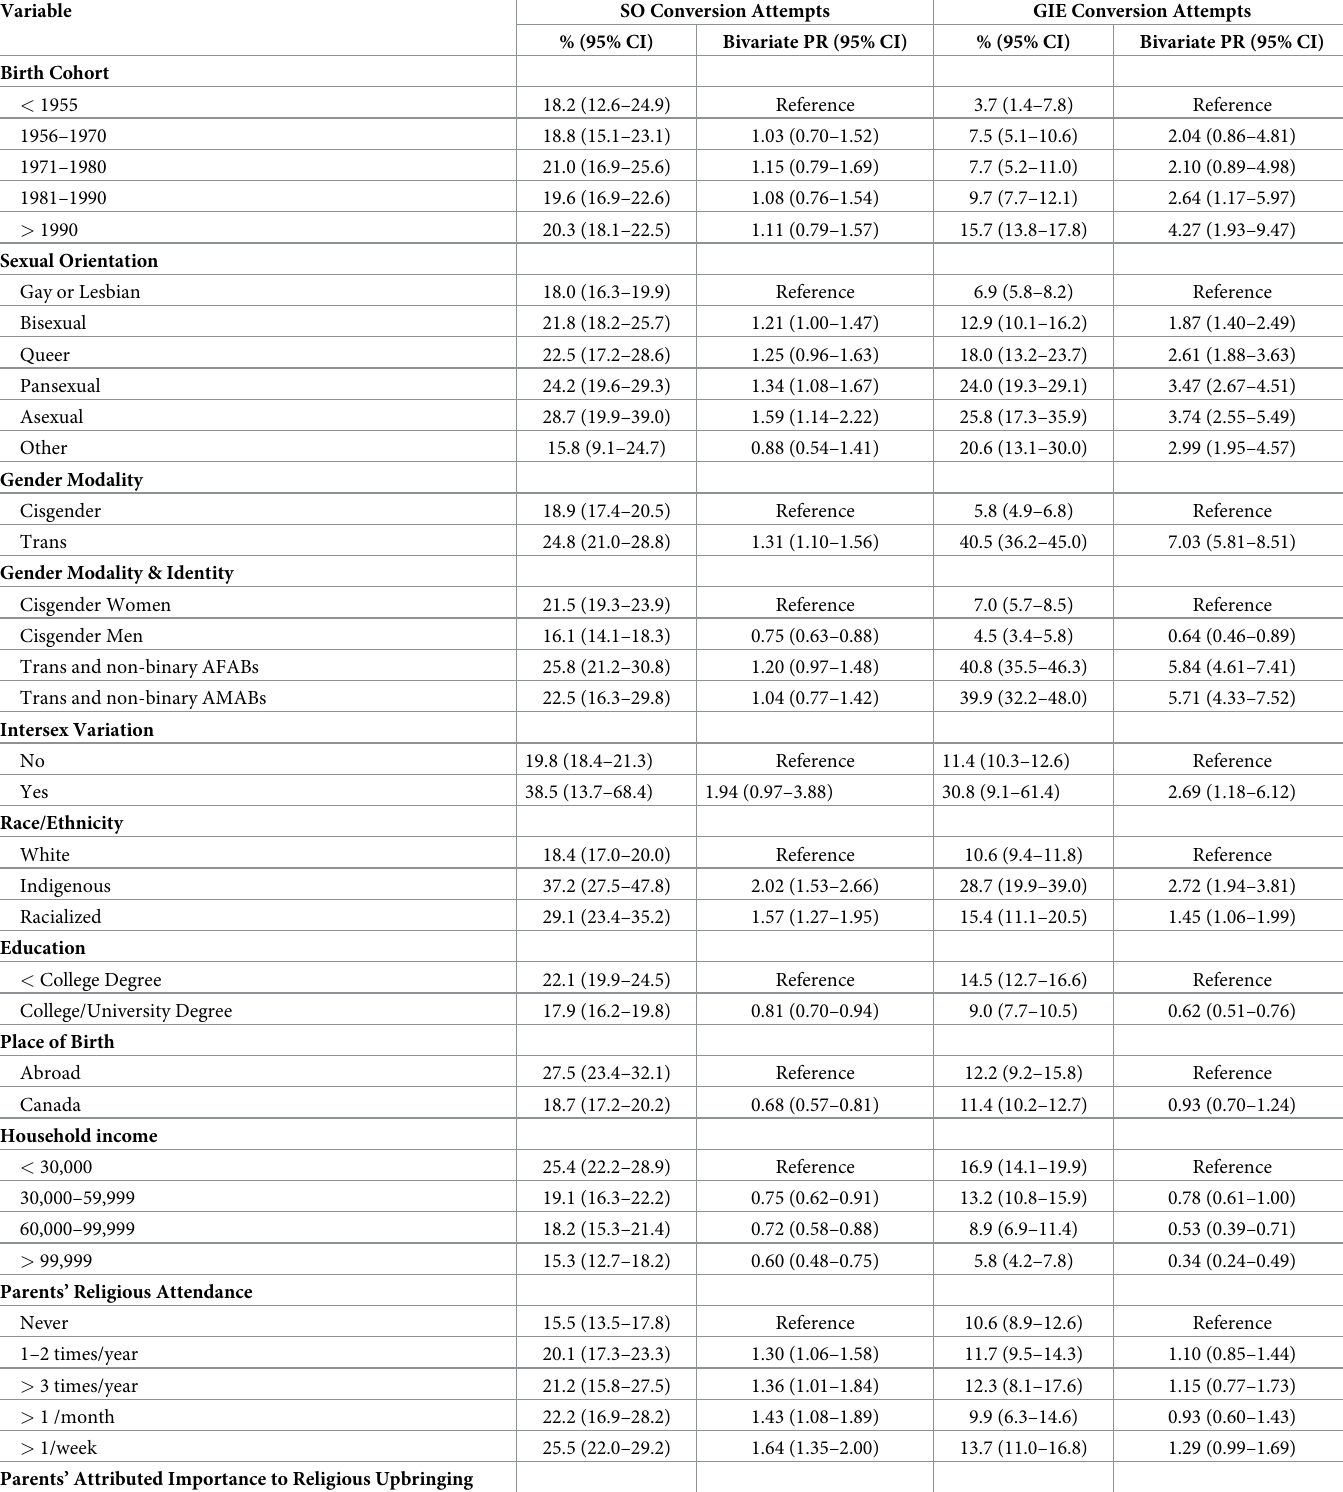
Table 5. Lifetime prevalence of SOGIE conversion attempts among LGBTQI2+ persons in Quebec, Canada, by participant